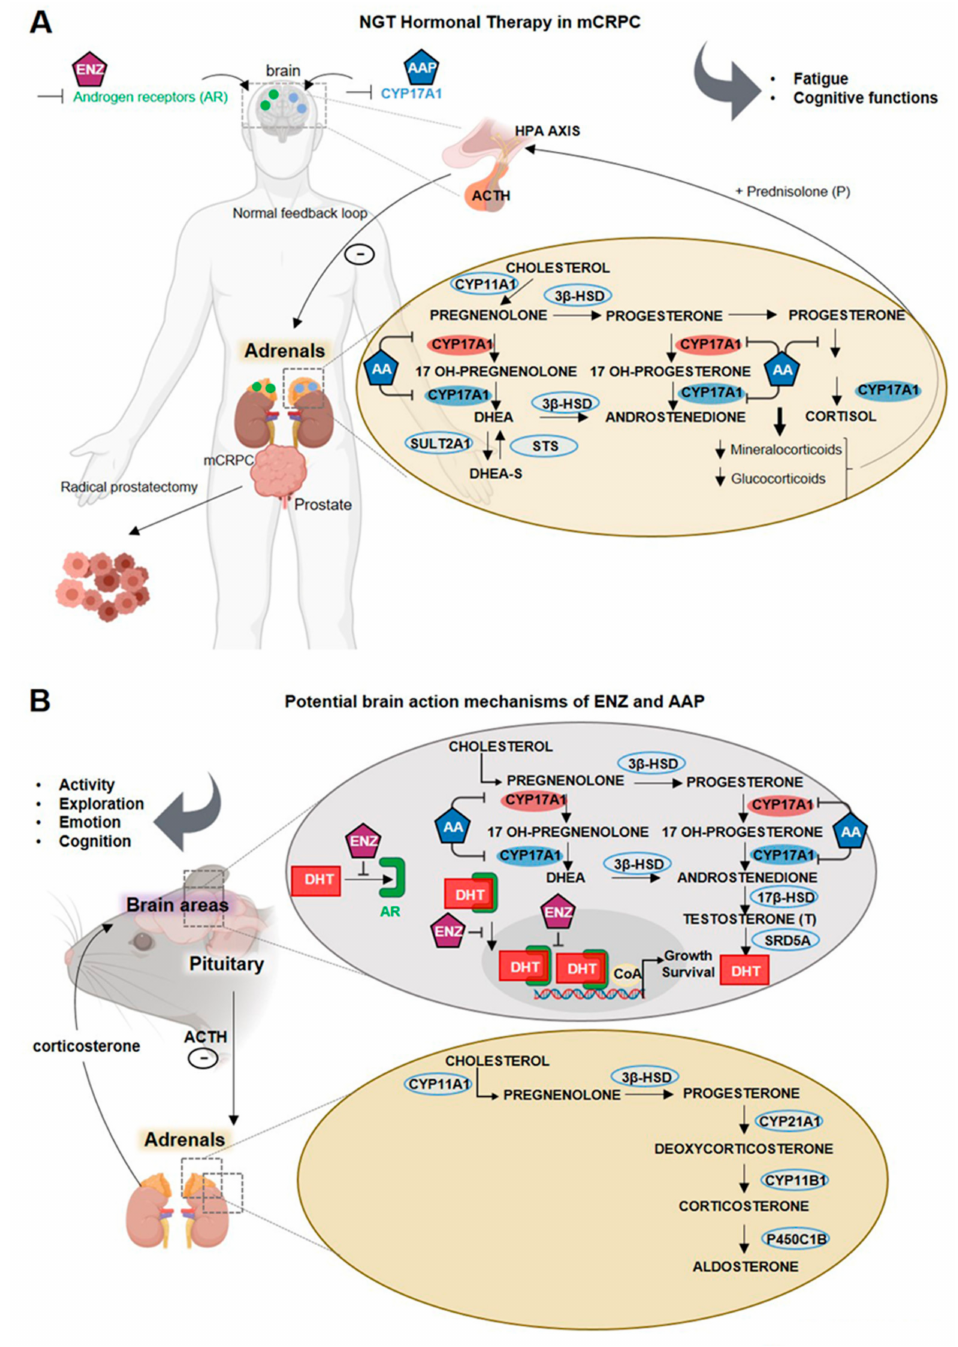
Figure 1. New generation therapy targeting androgen biosynthesis in addition to androgen deprivation therapy against metastatic castration-resistant prostate cancer: potential mechanisms of action on brain function using a mouse model. Note. ( A ) Schematic of enzalutamide (ENZ) and abiraterone acetate-prednisone (AAP) as treatment options for metastatic castration-resistant prostate cancer patients and of their sites of action such as prostate tissue, adrenals and potentially the brain. Cytochrome p450c17A1 (CYP17A1), an ER-localized enzyme expressed in both prostate and adrenal glands, and potentially in the human brain, plays a critical role in the androgen biosynthe- sis pathway. In the adrenals, CYP17A1 catalyzes two critical steps through its 17 α -hydroxylase and C17,20-lyase activities. The 17 α -hydroxylase activity of CYP17A1 converts pregnenolone to 17 α -pregnenolone and progesterone to 17 α -progesterone. The C17,20-lyase activity of CYP17A1 converts 17 α -hydroxypregnenolone to dehydroepiandrosterone (DHEA) and 17 α -hydroxyprogesterone